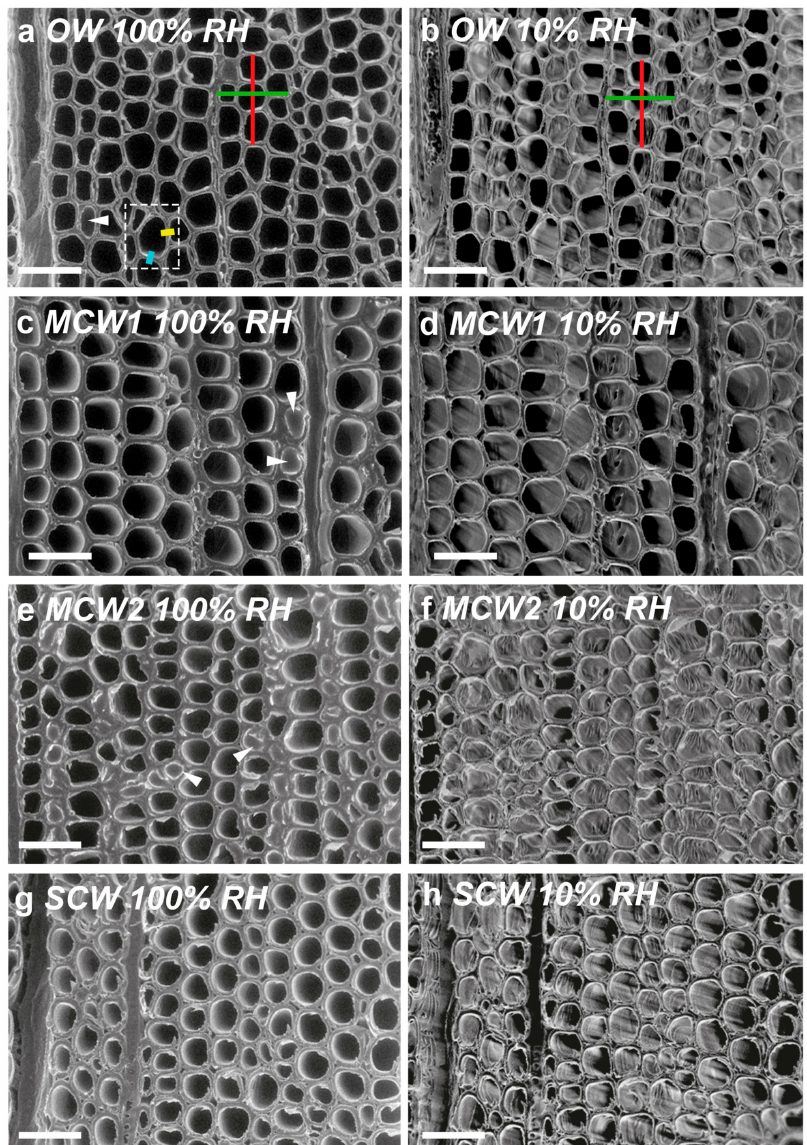
Figure 3. VP-SEM micrographs of cut transverse surfaces of discs showing the tracheids from the four corewood types in Tree 1. ( a ) OW at 100% RH, ( b ) OW at 10% RH, ( c ) MCW1 at 100% RH, ( d ) MCW1 at 10% RH, ( e ) MCW2 at 100% RH, ( f ) MCW2 at 10% RH, ( g ) SCW at 100% RH, ( h ) SCW at 10% RH. At 100% RH, free water fills some of the tracheid lumens (arrow heads). OW tracheids have the thinnest walls but the largest lumen diameters. The wall thickness increases and the lumen diameter decreases with increasing CW severity. The tracheids in all four corewood types are better aligned radially than tangentially. Shrinkage in the radial direction (red line in ( a )) and in the tangential direction (green line in ( a )) was investigated by measuring the dimensional changes between two reference points spanning three or four tracheids. Transverse wall shrinkage was also measured of tangential walls (light blue line) and of radial walls (yellow line) was also measured; the thickness of the double wall of two adjacent tracheids was measured. Scale bar = 50 µ